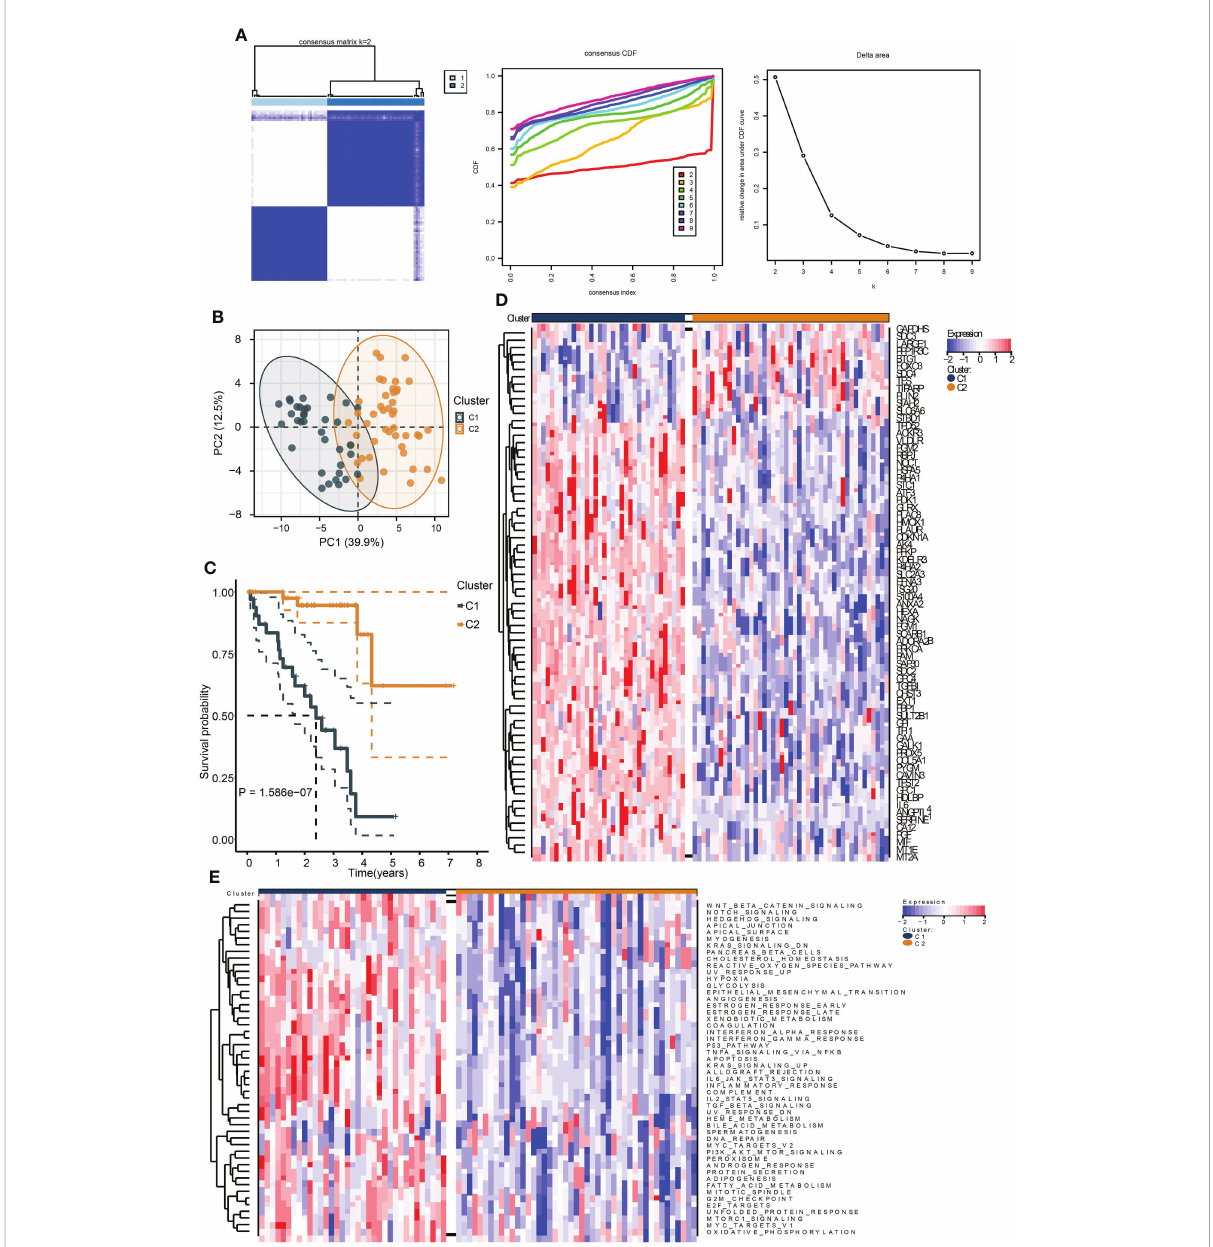
FIGURE 1 Identi fi cation of hypoxia-related subtypes of UM. (A) Consensus clustering heat map (left), CDF (middle), and the relative change in area under CDF curve (right) of the TCGA UM samples. (B) PCA plot showing the division results of consensus clustering. (C) Kaplan – Meier curve indicates the ability of subtypes to separate patient survival rate. (D) The expression heat map of the genes in hypoxia signature. (E) The enrichment heat map of the “ hallmark ” gene sets based on the DEGs between the